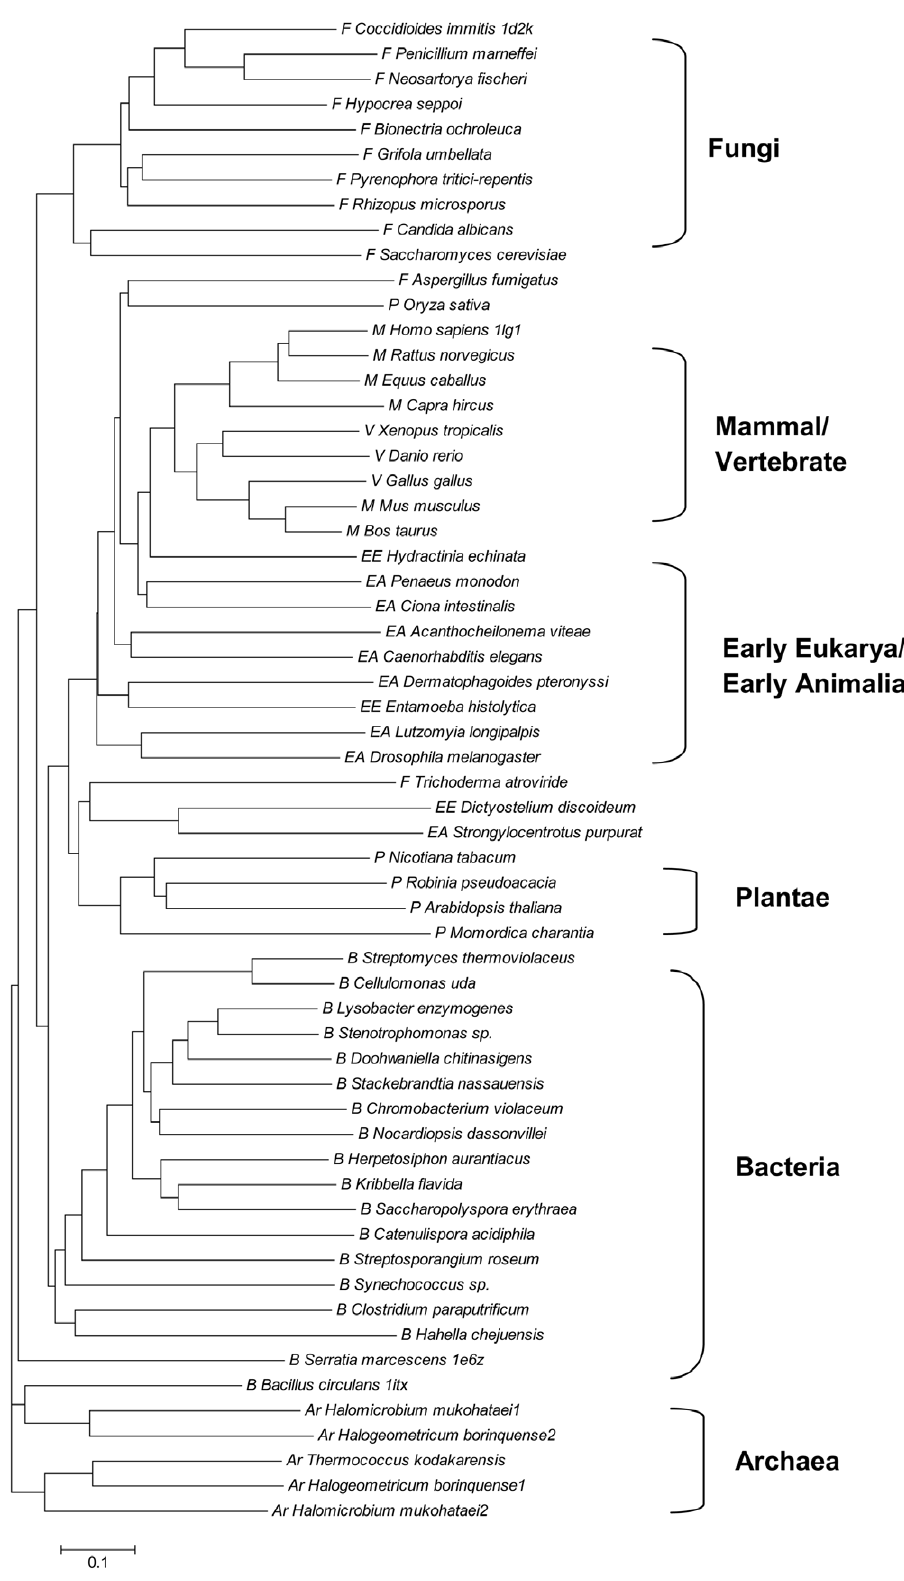
Figure 5. Phylogenetic analysis of the CID sequences from different lineages of organisms. The phylogenetic tree was constructed by the neighbour-joining method based on the CID sequences: five from Archaea, eighteen from Bacteria, twelve from Fungi, five from Plantae, three from early eukaryotes, eight from early Animalia, and nine from vertebrates (V) including six from mammals. The sequence names, corresponding GI numbers, and abbreviations are listed in Fig. 2 and Table S2. All the sequences were obtained from the protein database at the NCBI.